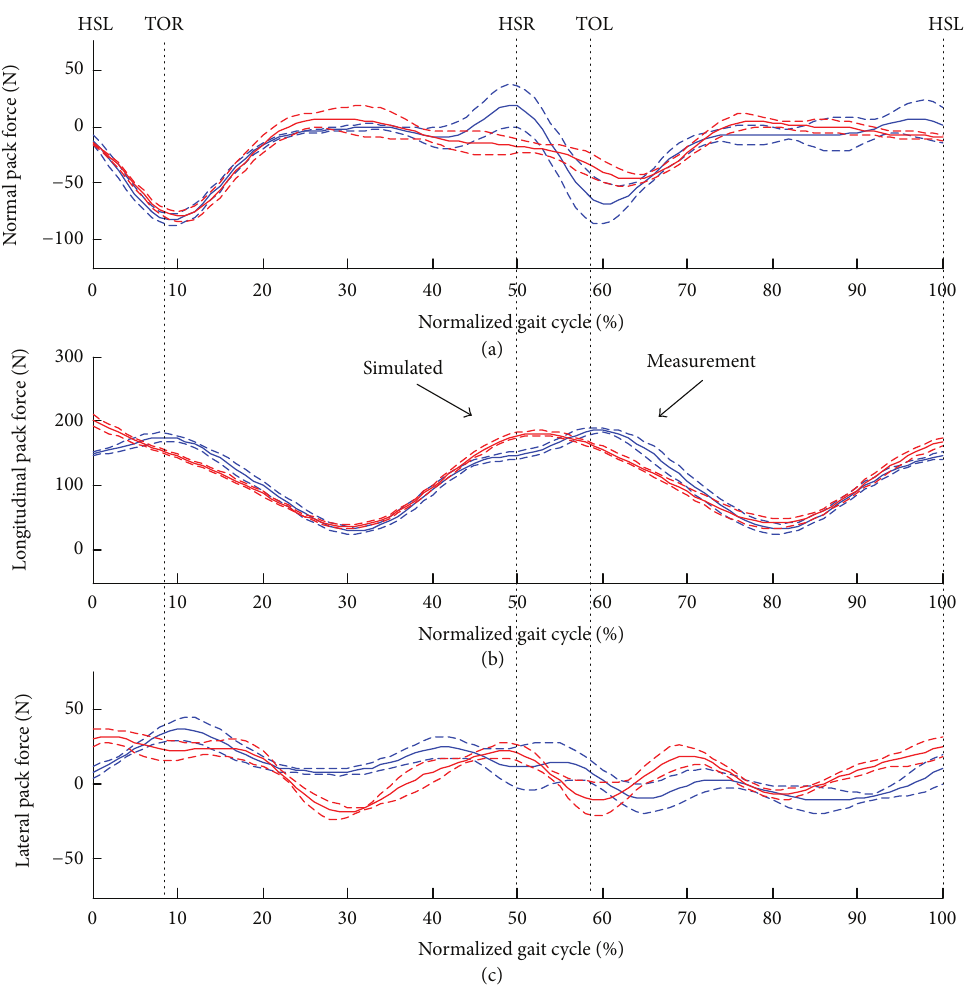
Figure 9: The simulated pack interaction forces in the pack coordinate system (mean (solid red line) ± one standard deviation (dashed red lines)): (a) longitudinal pack force, (b) normal pack force (c), and lateral pack force, compared with measured data (mean (solid blue line) ± one standard deviation (dashed blue lines)), for six repeated trials for one subject (age: 28yrs, weight: 71.8kg, height: 178 cm). The average walking speed was 1.93 ± 0.03 m/s, and the pack load was 11.5kg. The stance phase for the left limb is from 0 to 59%, and the swing phase is from 59% to 100%. The double support phase is from 0 to 9% and from 50 to